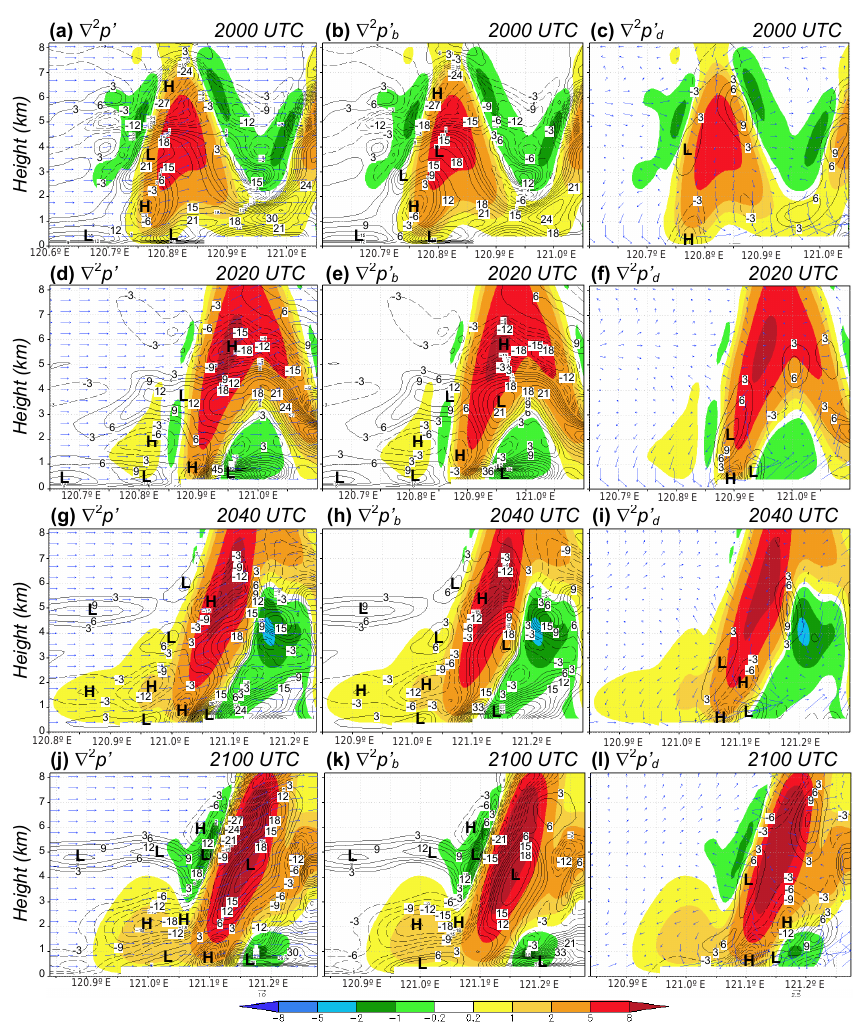
Figure 14. Vertical cross sections of model-simulated w (ms − 1 , color) and (a) ∇ 2 p (cid:48) (10 − 6 Pam − 2 ) and wind vectors (ms − 1 , reference vector at bottom) on section plain, (b) ∇ 2 p (cid:48) (computed from Eq. 3), and (c) ∇ 2 p (cid:48) (computed from Eq. 4) and vertical wind shear vector b d (10 − 3 s − 1 , in cardinal direction, reference vector at bottom) along the E–W segment through B1 and B2 at 20:00UTC on 11 June 2012 (cf. Fig. 10). All contour intervals are 3 × 10 − 6 Pam − 2 (zero line omitted, dashed for negative values), and letters H (L) denote corresponding high (low) pressure perturbations. (d–f, g–i, j–l) As in panels (a–c) , except at 20:20, 20:40, and 21:00UTC (WNW–ESE segments for 20:40 and 21:00UTC, cf. Fig. 10),